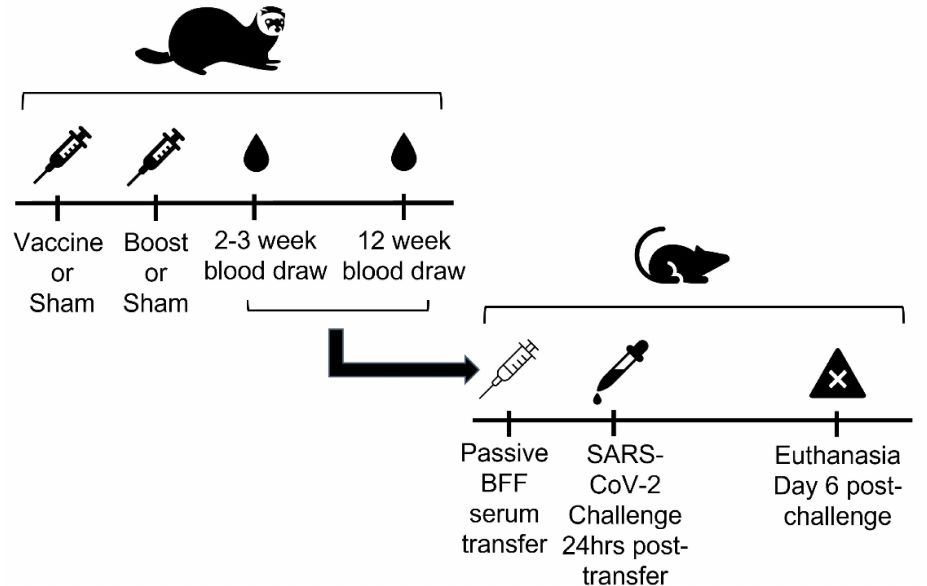
Figure 1. Experimental design and timeline of the immunization of black-footed ferrets and subse- quent passive transfer study conducted in transgenic mice with serum from BFF. BFF were vaccinated with SARS-CoV-2 S1 subunit protein or given a sham inoculation, then a subsequent boost of the same vaccination or sham. They were bled 2–3 weeks and 12 weeks post-boost. This serum was used for a passive serum transfer into transgenic mice. Mice were subsequently challenged with SARS-CoV-2 to determine the protective effect of the BFF serum. The mice were euthanized 6 days